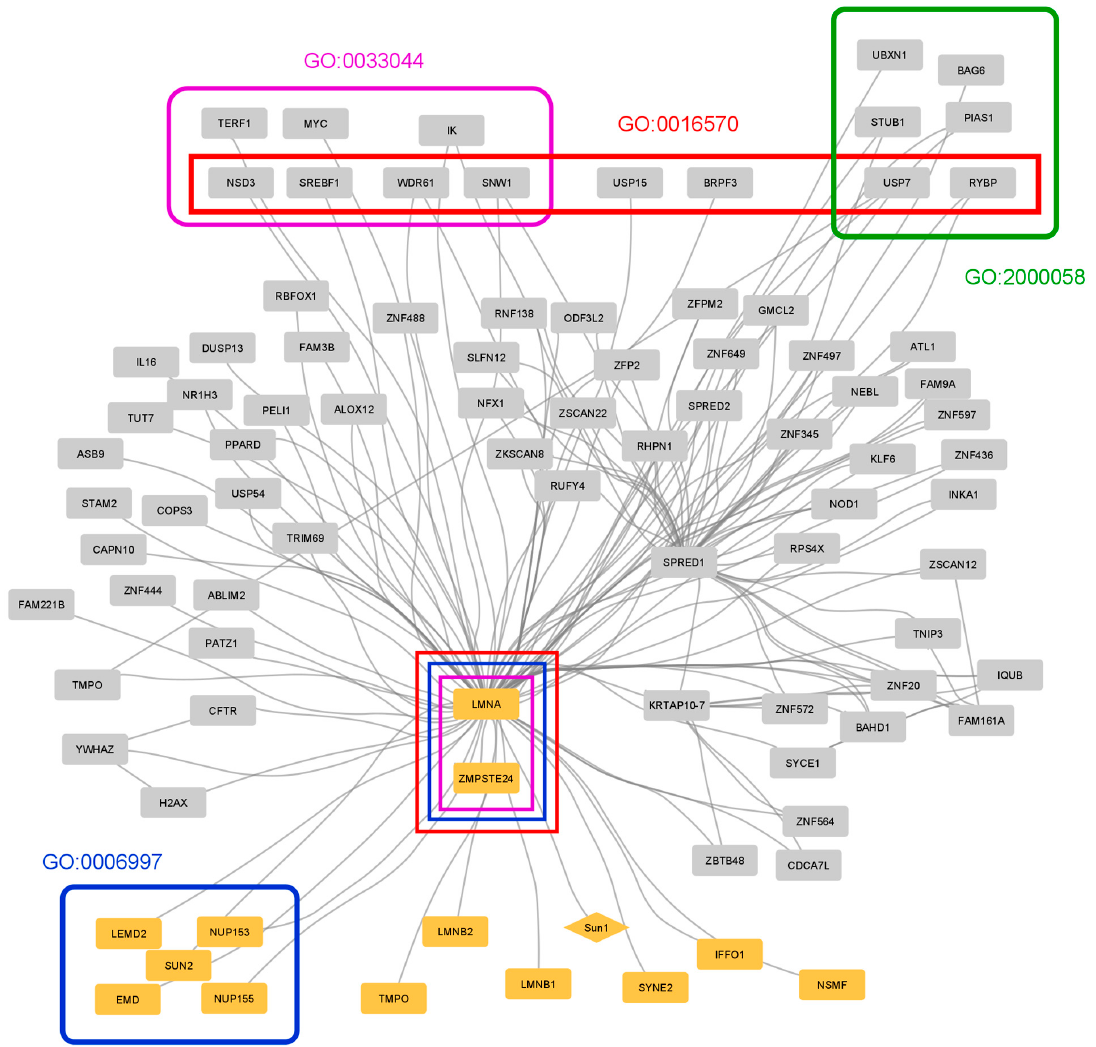
Figure 4. Interaction network for lamin A (LMNA), the protein responsible for Hutchinson–Gilford Progeria Syndrome. The interaction data and the GO annotation were collected using the Network Analysis and Functional Enrichment tools provided by NucEnvDB, respectively. This network is composed of 142 edges between 90 nodes, 14 NE proteins (orange), and 76 other proteins (gray). All are human proteins except for Sun1 (diamond), which is a Mus musculus protein, with its interaction indicated from experimental trials involving mice. Four GO terms regarding functions related to chromosomes (purple), the nucleus (blue), histones (red), and ubiquitin-dependent degradation (green) are shown with the associated proteins within frames of the same color. Most proteins only interact with LMNA; however, there are two other proteins with more than 10 interactions, KRTAP10-7 and SPRED1. (GO:2000058: regulation of ubiquitin-dependent protein catabolic